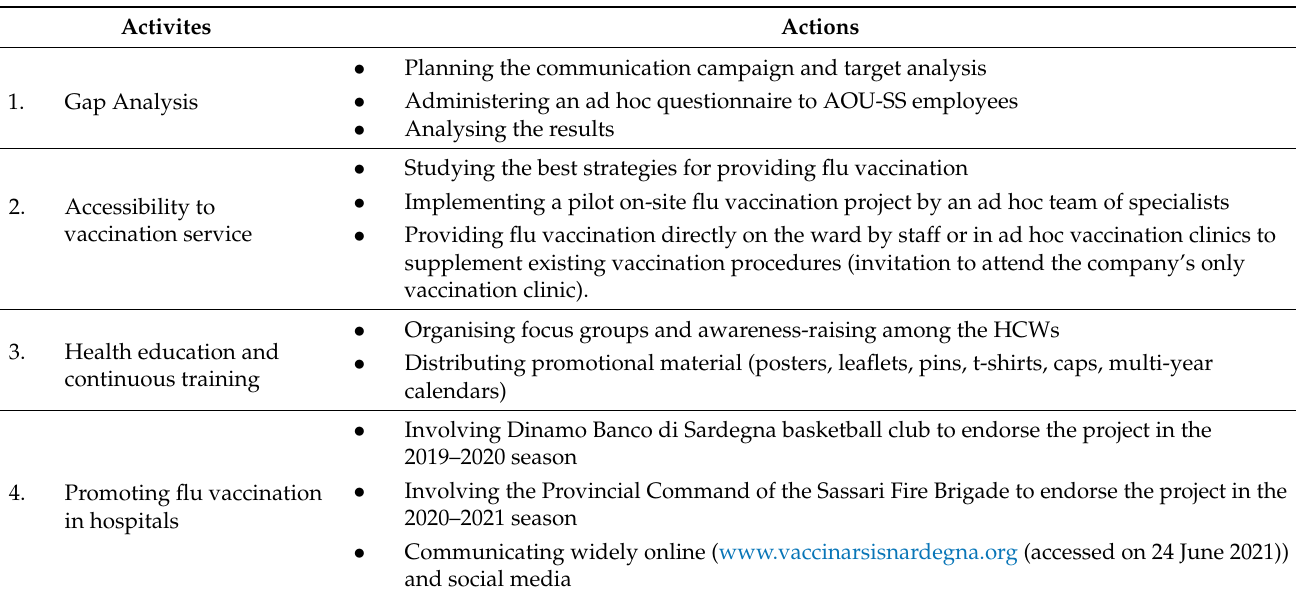
Table 4. Phases and activities of the flu vaccination